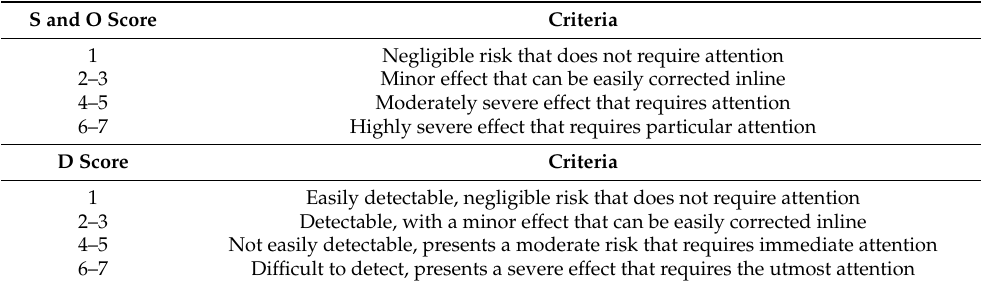
Table 2. Failure mode and effect analysis (FMEA) score criteria for establishing critical method